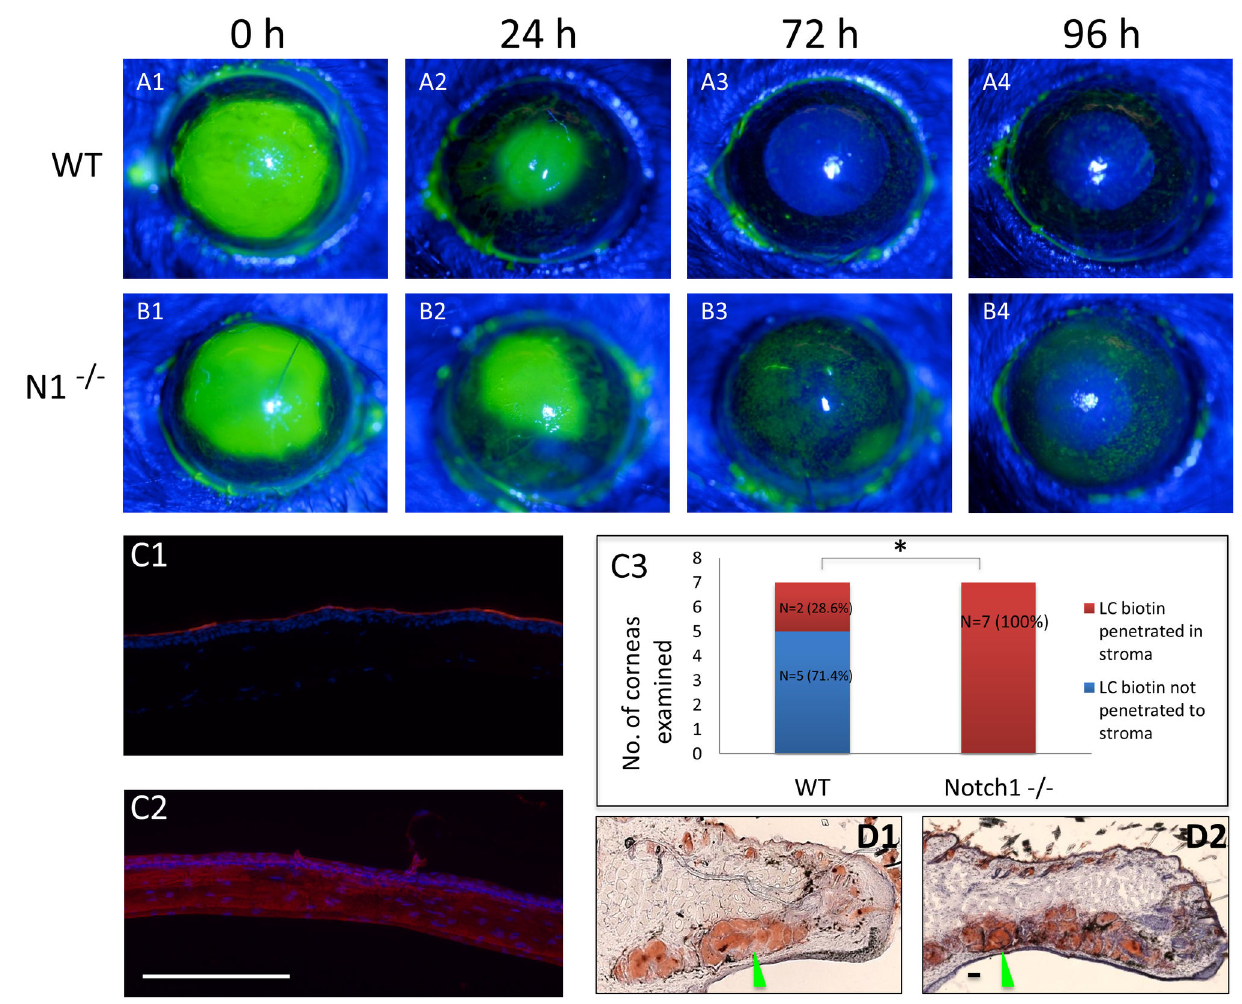
Figure 3. Notch1 -/- corneal epithelium is delayed in recovering its barrier function after wounding. Fluorescein staining of WT (A1-A4) and Notch1 -/- (B1-B4) eyes immediately (0 h), 24, 72 and 96 hours after 2.0 mm central corneal epithelial debridement wounds; indicating a delay in barrier recovery in Notch1 -/- eyes compared to WT. LC-biotin barrier function test at 96 hours post- wounding showing that the WT cornea is impermeable to LC-biotin (C1) while in the Notch1 -/- cornea LC-biotin has penetrated into the stroma (C2). LC-biotin staining showed penetration of the molecule into the stroma in 100% (7/7) of Notch1 -/- mice compared to only 28.6% (2/7) of WT littermates at 96 hours ( p =0.021). (C3). Oil Red O staining confirmed the presence of oil producing meibomian glands (green arrow head) in both WT (D1) and Notch1 -/- (D2) at one week after 4-OHT treatment. Red: rhodamine, Blue: DAPI; scale bar: 100 µm. doi: 10.1371/journal.pone.0069113.g003 pattern of ZO-1 staining (mean fluorescent intensity for Notch1 -/- was 117.6±32.9 vs 122.4±48.3 for WT, P = 0.429) suggesting that tight junction formation can ultimately be compensated by other means in vitro .